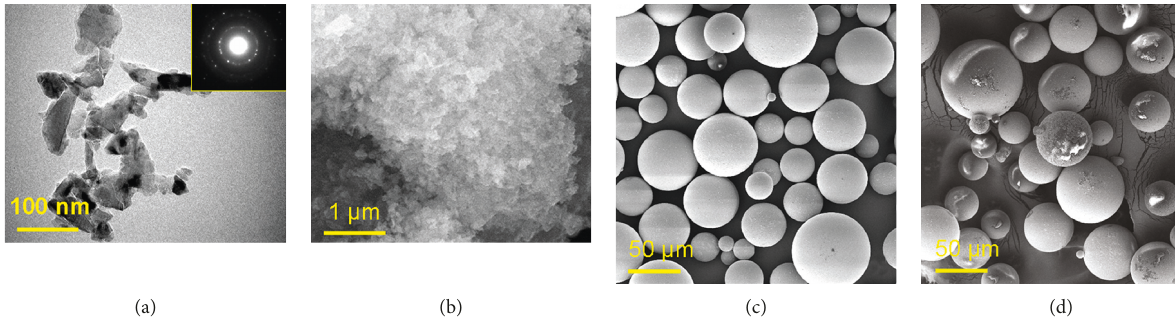
Figure 1: (a) TEM image of ND powder, and (inset) corresponding selected area electron diffraction (SAED) pattern showing crystalline structure; (b) SEM micrograph of ND powder; SEM micrographs of (c) pure PMMA; (d) PMMA/ND mixture.